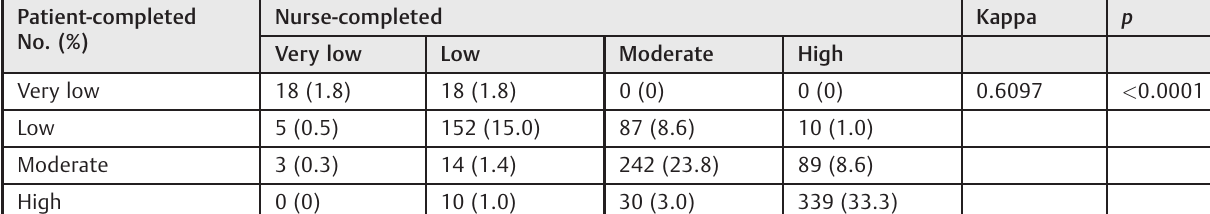
Table 4 Agreement level by strati fi cation between patient-completed and nurse-completed Caprini risk score ( n ¼ 1017) Patient-completed No. (%)